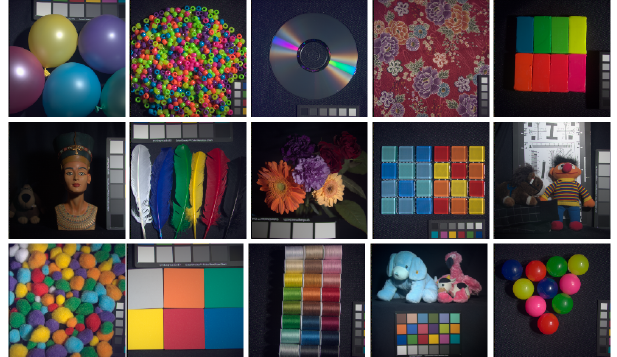
Figure 10. Yasuma et al. [41] rendering of the hyperspectral dataset used in Experiments 2 and 3